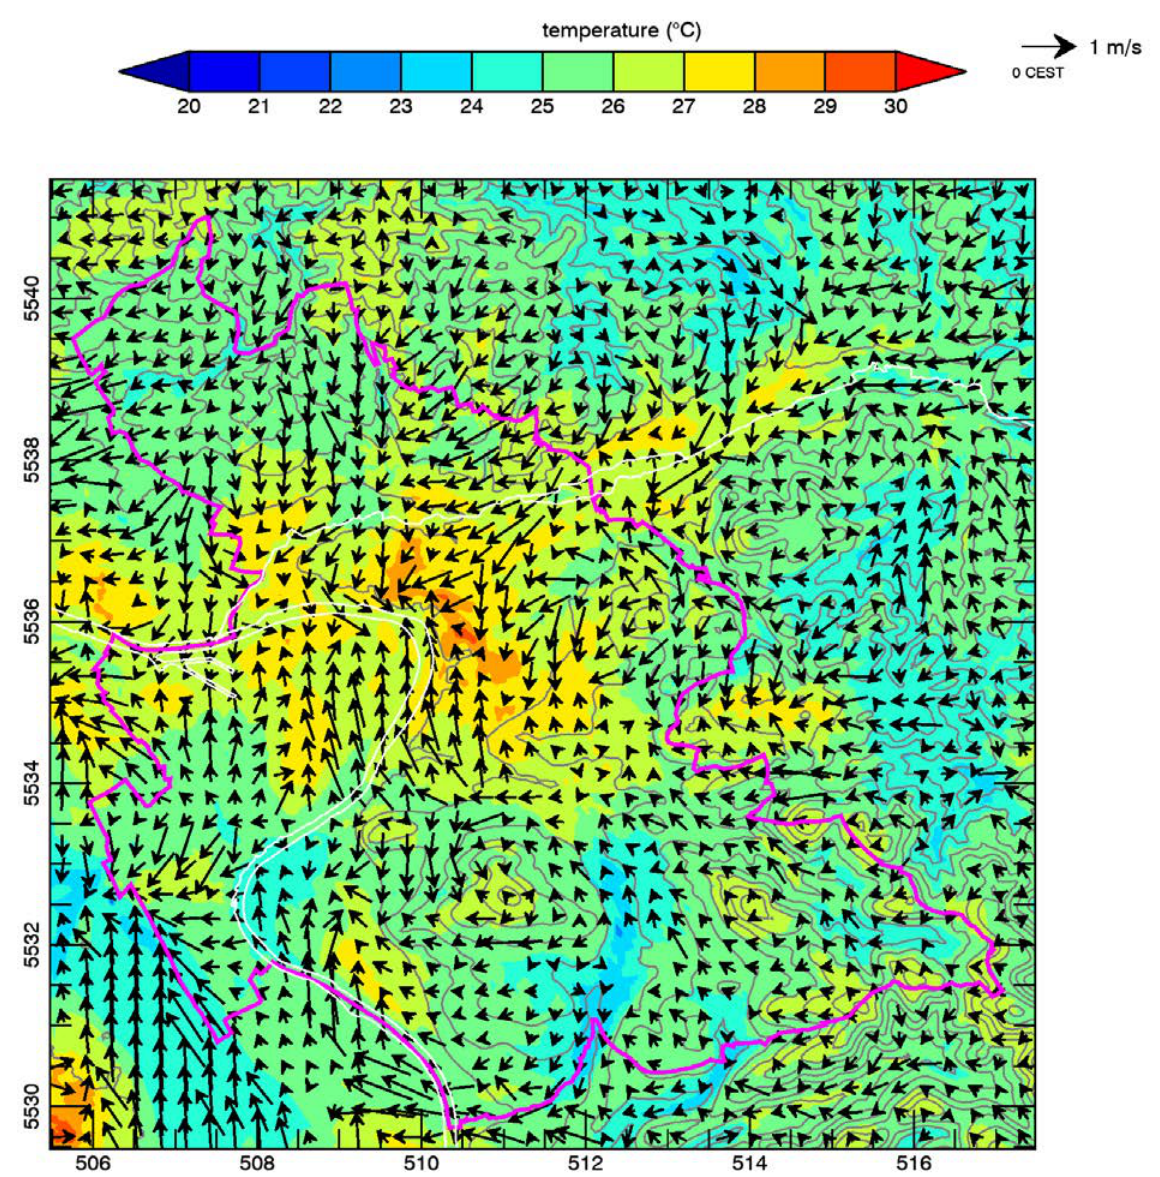
Figure 4. 00:00 CEST map of the air temperature (°C) and wind vectors (m/s) within the 12 km × 12 km city subdomain at 5 m above ground level. Terrain elevation contour lines are shown in grey, rivers in white, and the city border of Aschaffenburg in magenta.